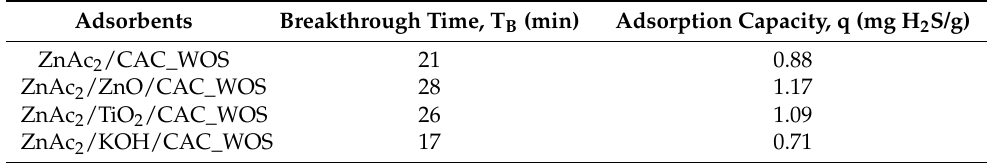
Table 3. Adsorption capacity of CS/CAC_WOS